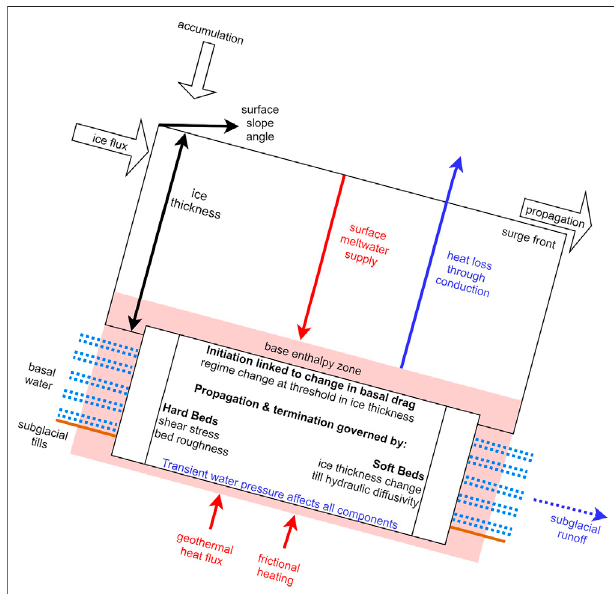
FIGURE 2 | Enthalpy components based on Benn et al. (2019a). Enthalpy gains are in blue, enthalpy losses in red. Initiation of fl ow velocity through changes in basal drag are independent but linked to the enthalpy framework trough the impact of effective pressure.